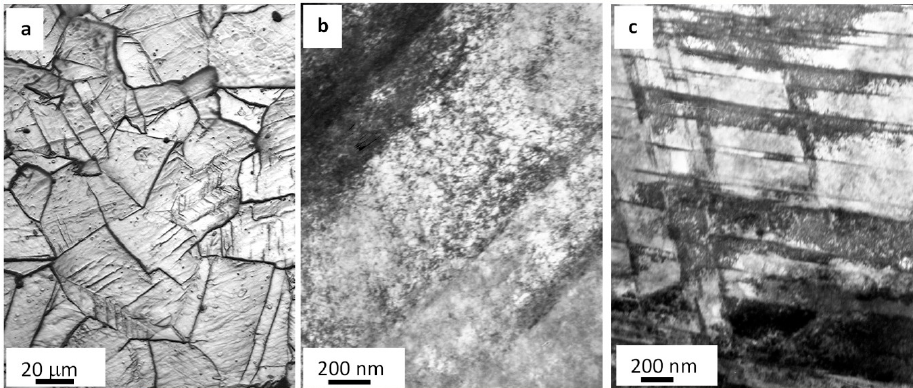
Figure 2. The structure of AISI 310S steel before fatiguing: ( a ) optical microscopy of an etched microsection and ( b , c ) TEM.